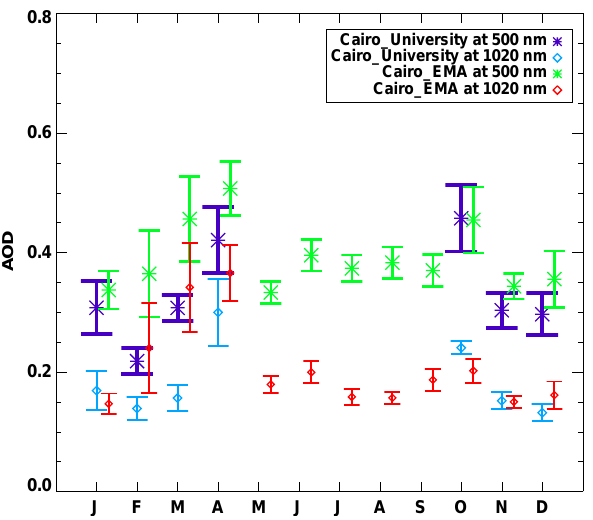
Fig. 4. AERONET AOD observations at 500 (purple) and 1020 (red) nm over Cairo for Cairo University (from October 2004 to April 2005) and Cairo EMA (from April 2005 to March 2006) sta- tions. The vertical bars represent standard errors.